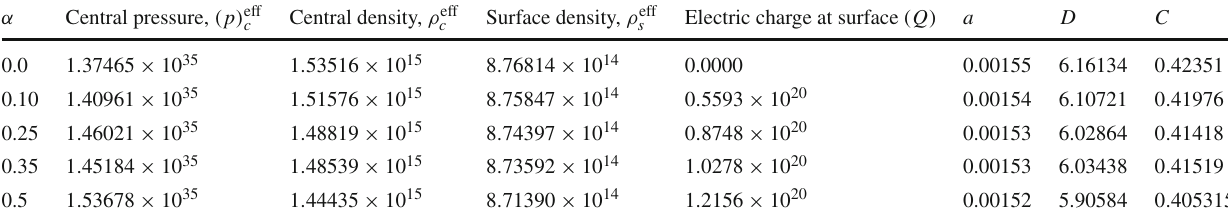
Table 1 The numerical values of physical parameters and constants of the compact star of mass M = 1 . 04 M (cid:14) and radius R = 7 . 67 km for different values of α α Central pressure, ( p ) eff ρ eff ρ eff c Central density, c Surface density, s Electric charge at surface ( Q ) a D